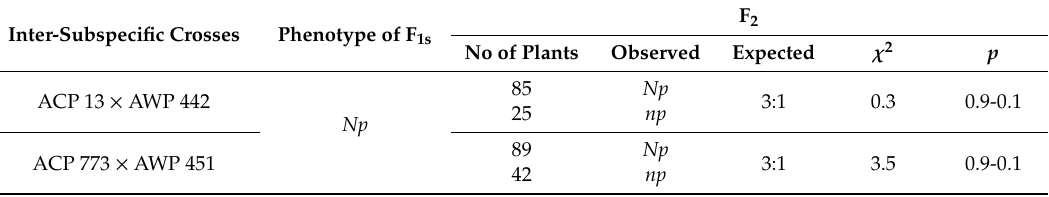
Table 4. Chi-square ( χ 2 ) analyses of neoplasm ( Np ) vs. free-from-neoplasm ( np ) progeny derived from inter-subspecific crosses between P. sativum subsp. sativum and P. sativum subsp. elatius. Inter-Subspecific Crosses Phenotype of F 1s ACP 13 × AWP 442 ACP 773 × AWP 451